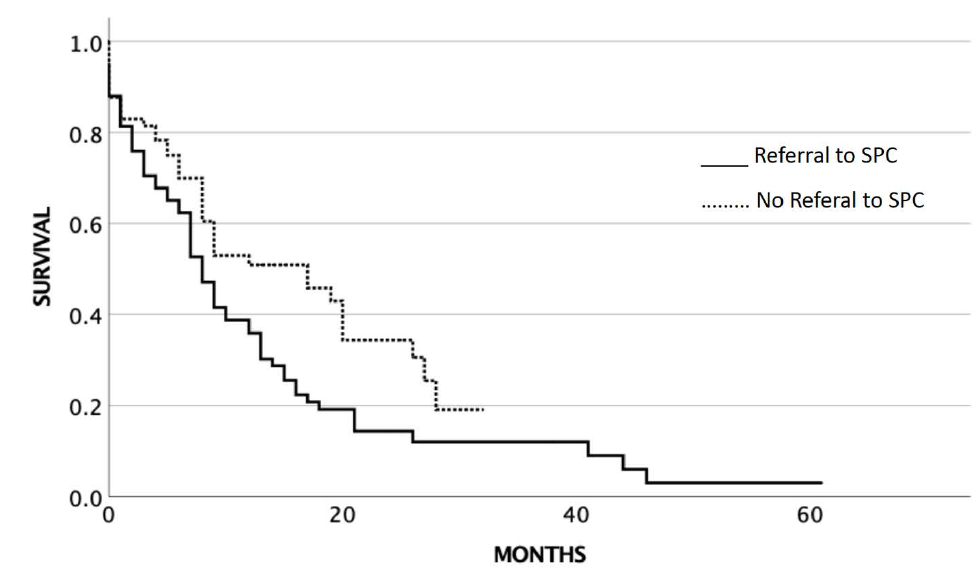
Figure 2. Overall survival related to SPC service in stage III/IV SCLC.